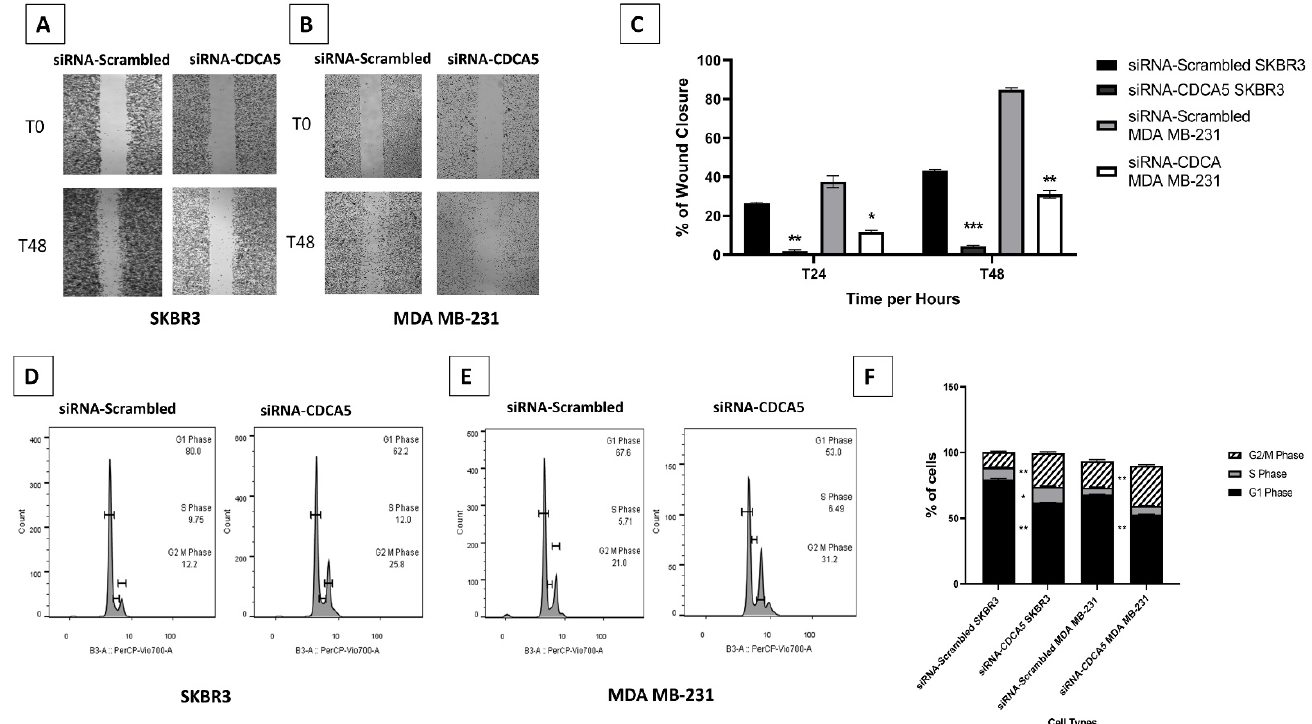
Figure 4. CDCA5 cancer cell migration and cell cycle result. ( A – C ), Representative images of wound closure assay in SKBR3 & MDA-MB 231 BC cell lines transfected with scrambled siRNA control and CDCA5 siRNA, wound measuring was performed in ImageJ software. ( D – F ). Representative images and quantification of cell cycle progression by flow cytometry in the SKBR3 and MDA MB-231 BC cell lines transfected with CDCA5 siRNA compared to control scrambled cells. p values are indicated